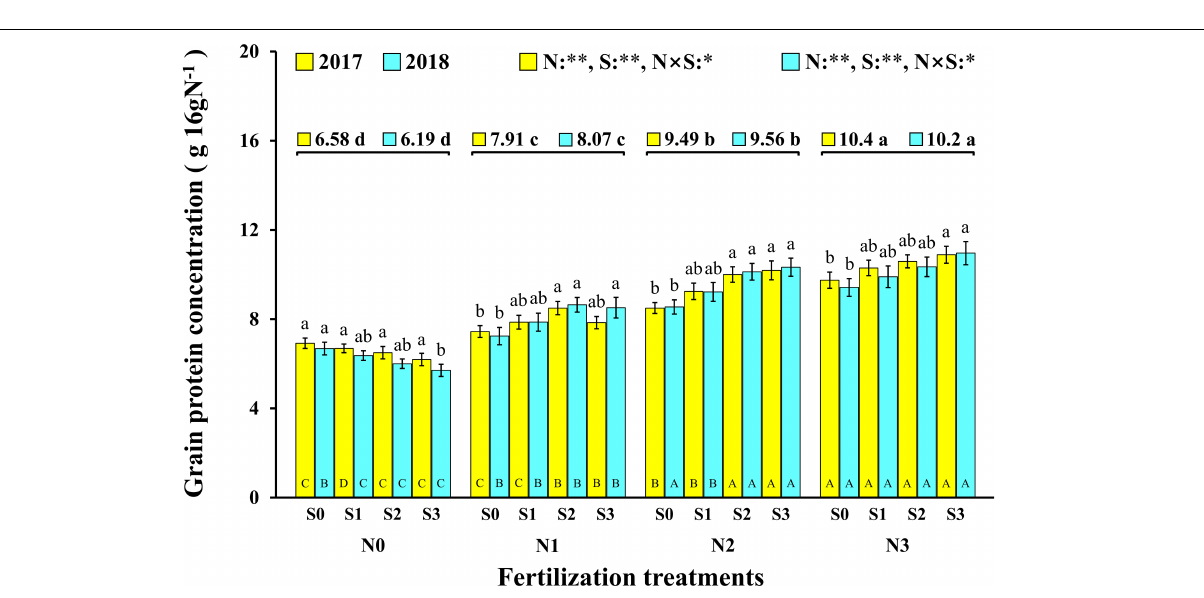
Frontiers in Plant Science |